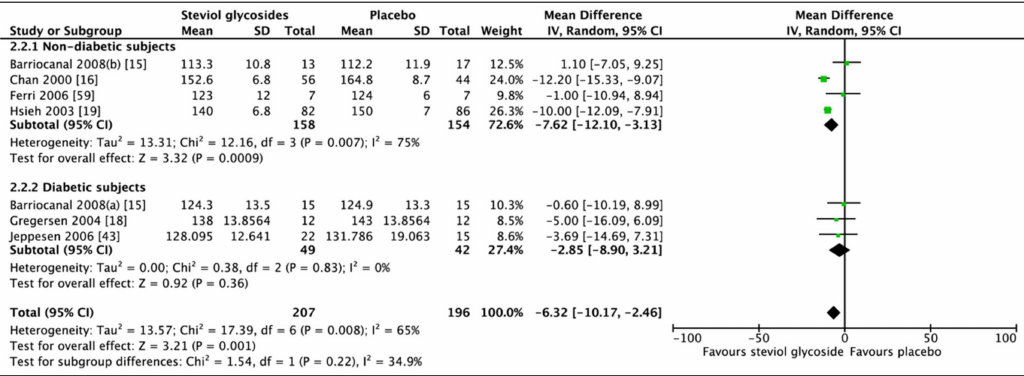
Figure 5. E ff ect of SGs on systolic blood pressure (SBP, mmHg) CI: confidence interval; MD: mean di ff erence; RCTs: randomized controlled trials; SD: standard deviation.